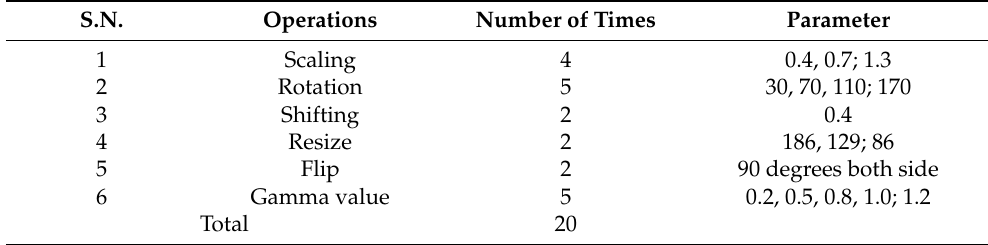
Table 1. Parameters of Data